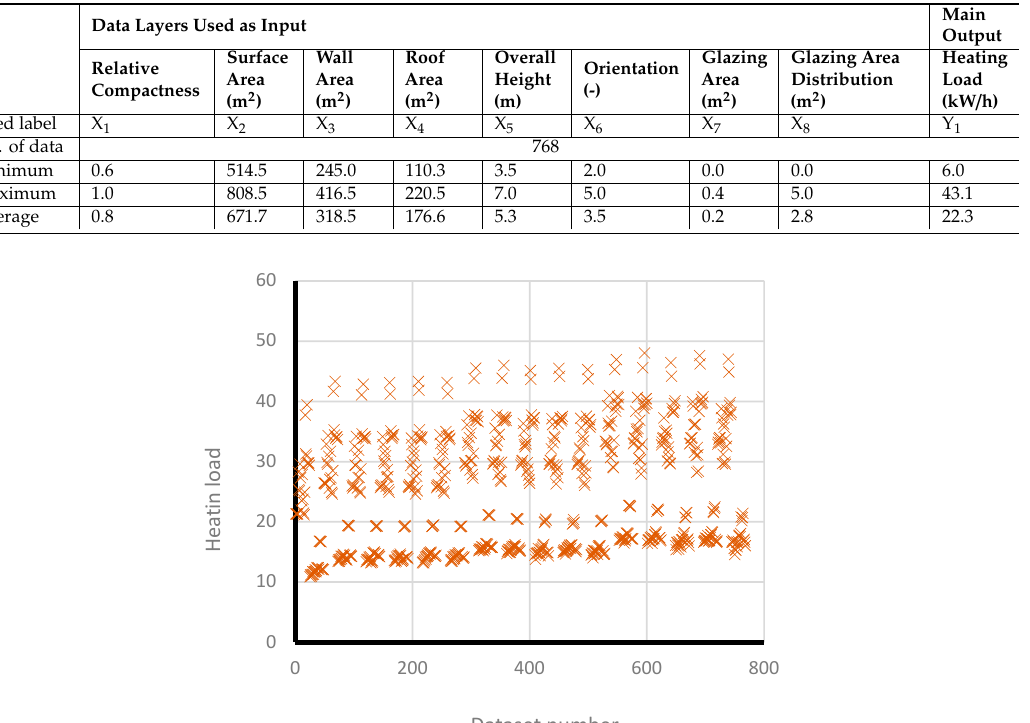
Figure 3. Schematic view of some of the output data layers (i.e., heating load).